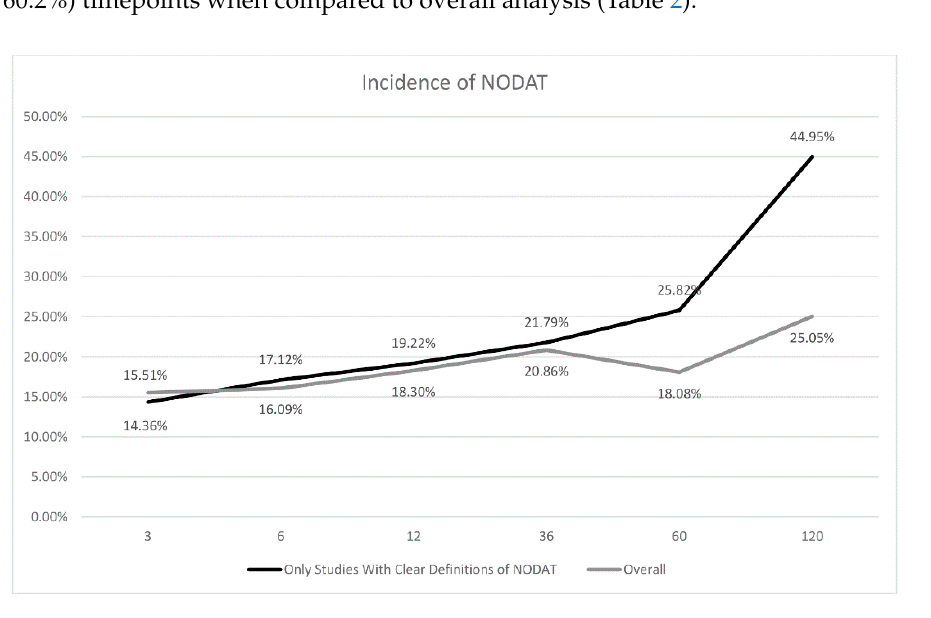
Figure 5. Incidence of New-Onset Diabetes after Transplantation (NODAT) at Various Timepoints.